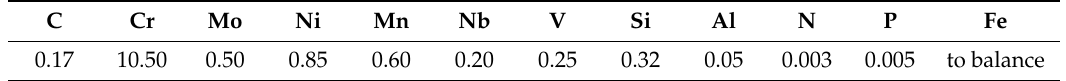
Table 1. Chemical composition of the investigated Cr martensitic steel (wt